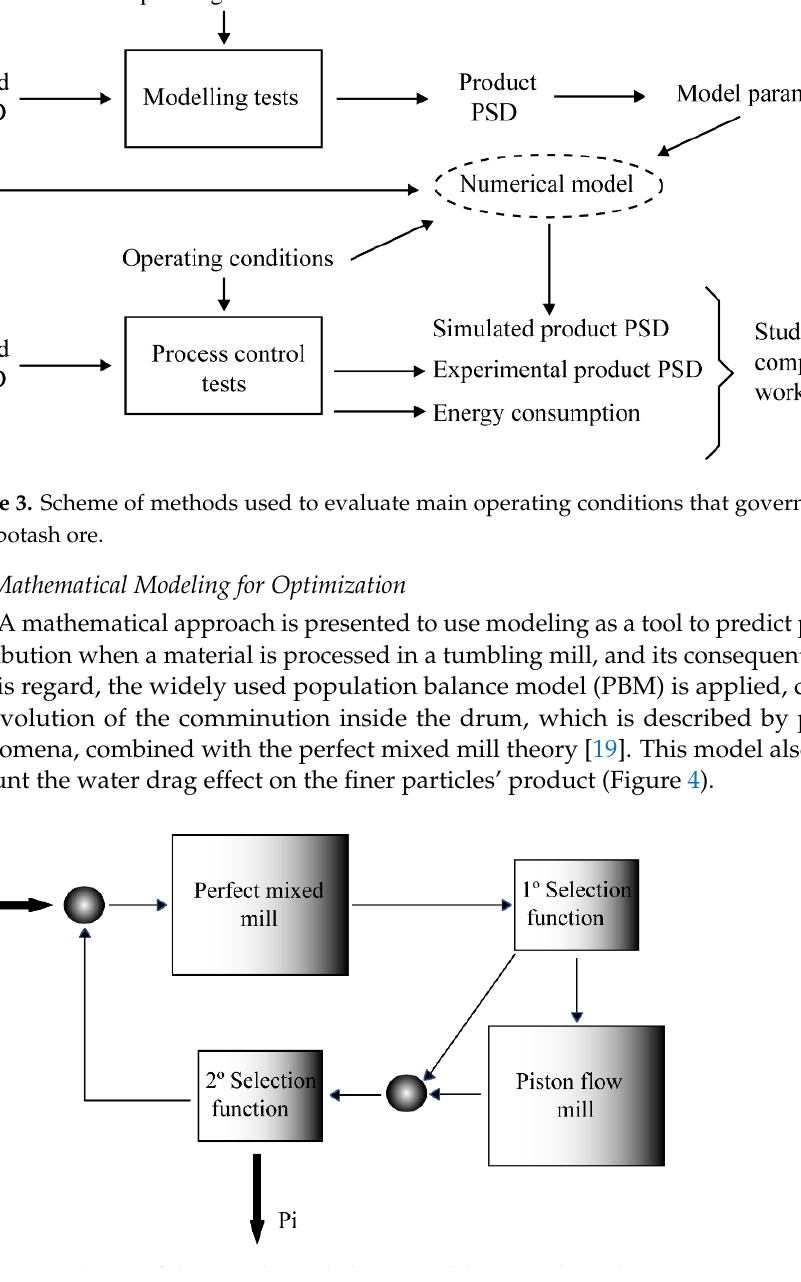
Figure 4. Scheme of the population balance model approach, with a perfect mixed mill combined with the piston flow process.